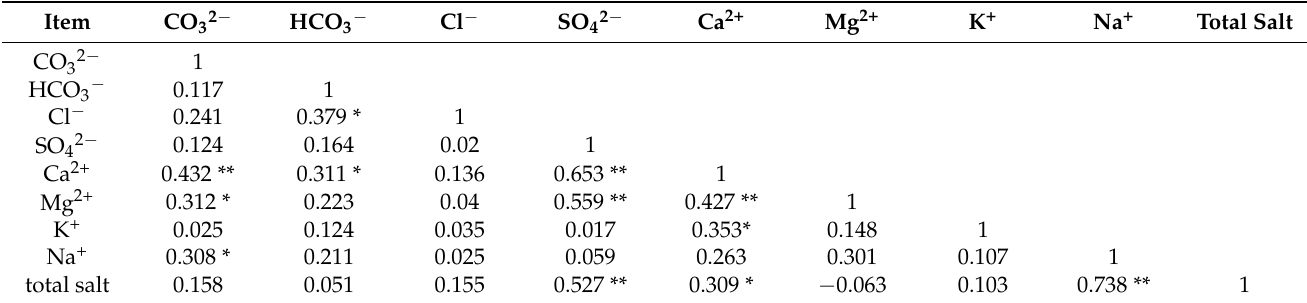
Table 1. Correlation coefficients between total salt and eight major ions in Area A.